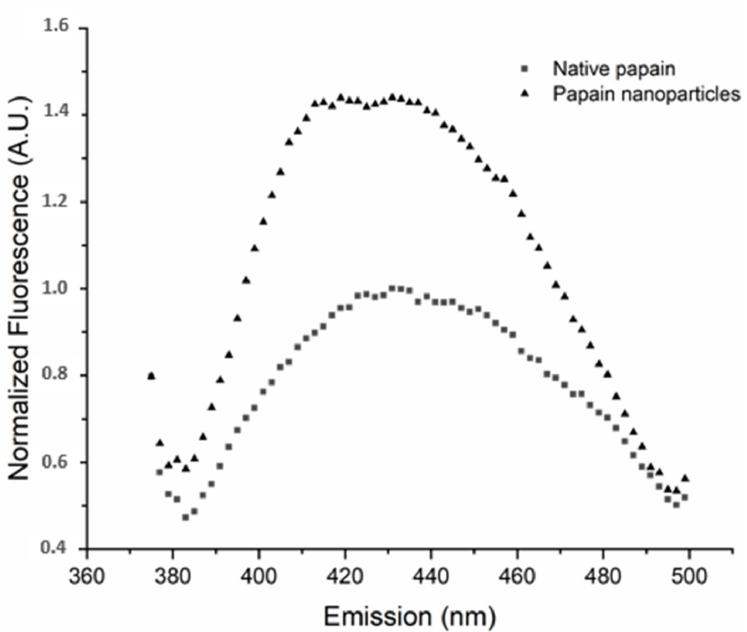
Figure 1. Bityrosine fluorescence spectra of native papain and papain nanoparticles obtained using excitation wavelength ( λ Ex) of 350 nm and emission wavelength ( λ Em) scanning ranging from 350 to 500 nm, with excitation and emission bandwidths of 9 and 15 nm. (A.U. = arbitrary unit).